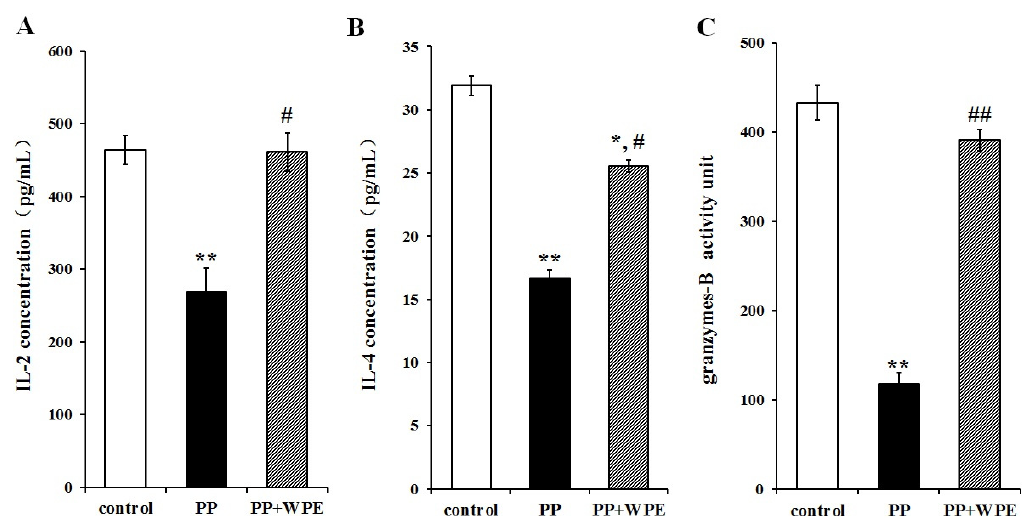
Figure 4. Effect of WPE on select cytokine/granzyme production in splenocytes exposed to PP. Splenocytes were cultured for 48 h in the presence of PP (10 − 4 M) or WPE (1.0 μ g/mL) together with PP. Levels of ( A ) IL ‐ 2; ( B ) IL ‐ 4; and ( C ) granzyme B released into culture media were then measured by ELISA. Results shown are means ± SD of three separate experiments. * p < 0.05 or ** p < 0.01 vs. untreated control; # p < 0.05 or ## p < 0.01 vs. PP treatment.